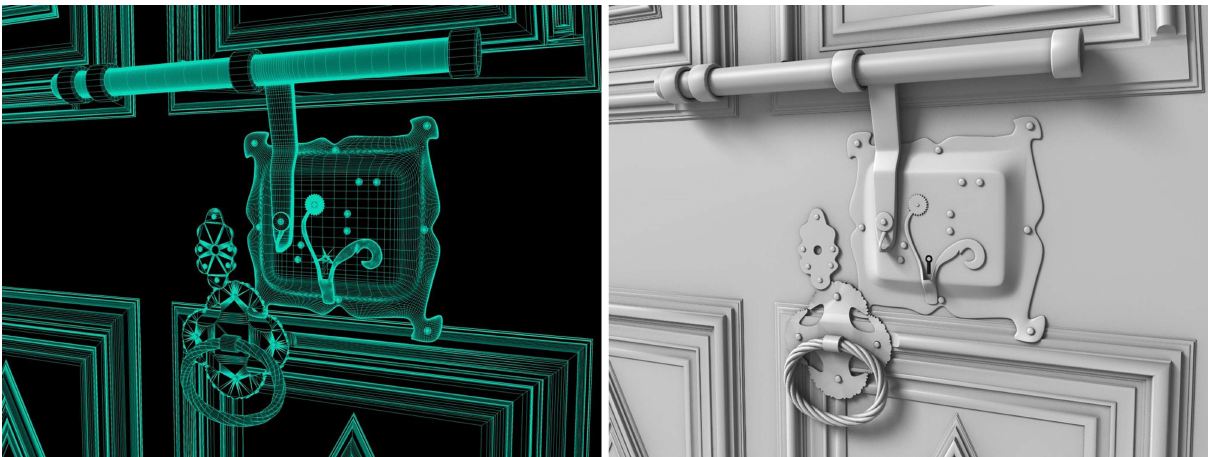
Figure 4. San Romedio Chapel, San Romedio hermitage (TN): modelling of constructive details for the representation of historical and artistic assets (authors: Stefano Longo, Lucia